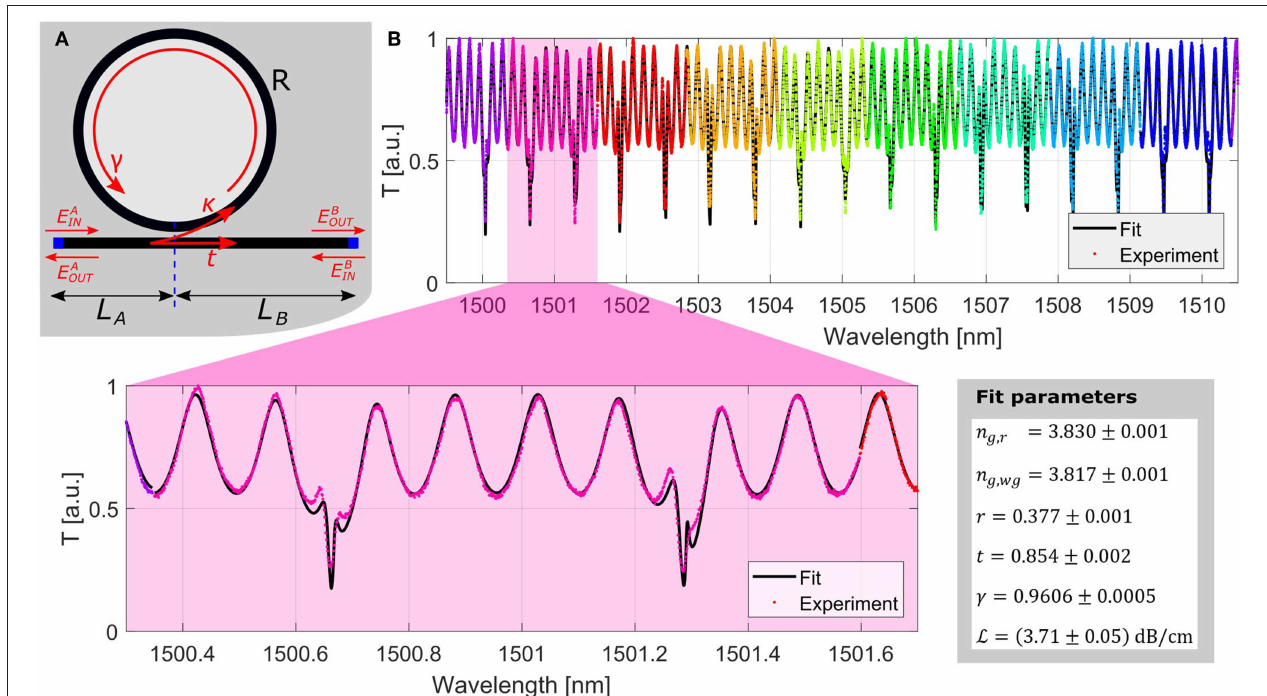
FIGURE 2 | (A) Sketch of the device described in this work, showing the main parameters of the model. (B) Experimental spectrum of the resonator (dots) and corresponding fit (solid black lines). On the bottom, part of the fitted spectrum is enlarged. In the inset, the fit parameters are reported.